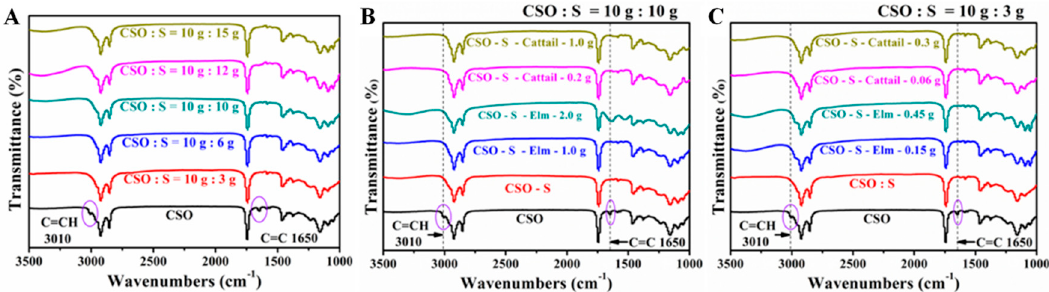
Figure 8. FT-IR spectra of CSO and bio-based polysulfide composites. ( A ) Different sulfur content, ( B ) 10.0 g CSO + 10.0 g S + different fillers, ( C ) 10.0 g CSO + 3.0 g S + different fillers.